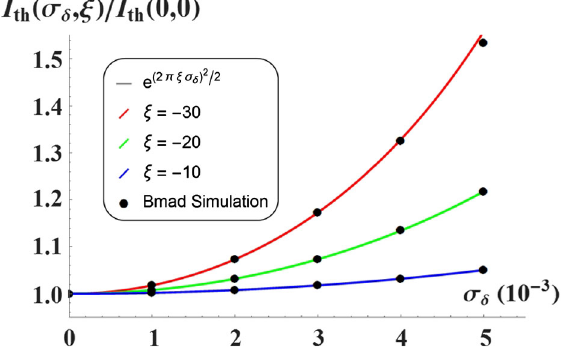
FIG. 23. The I results from tracking a Gaussian beam (2000 th particles per bunch) through a “ one-HOM, N p ¼ 2 ” lattice with different ( σ δ , ξ ). The three curves correspond to the factor e − ð 2 πξσ δ Þ 2 = 2 with different ξ , and the black dots are the simulation results. Parameters: same as in case A (See Fig. 14).